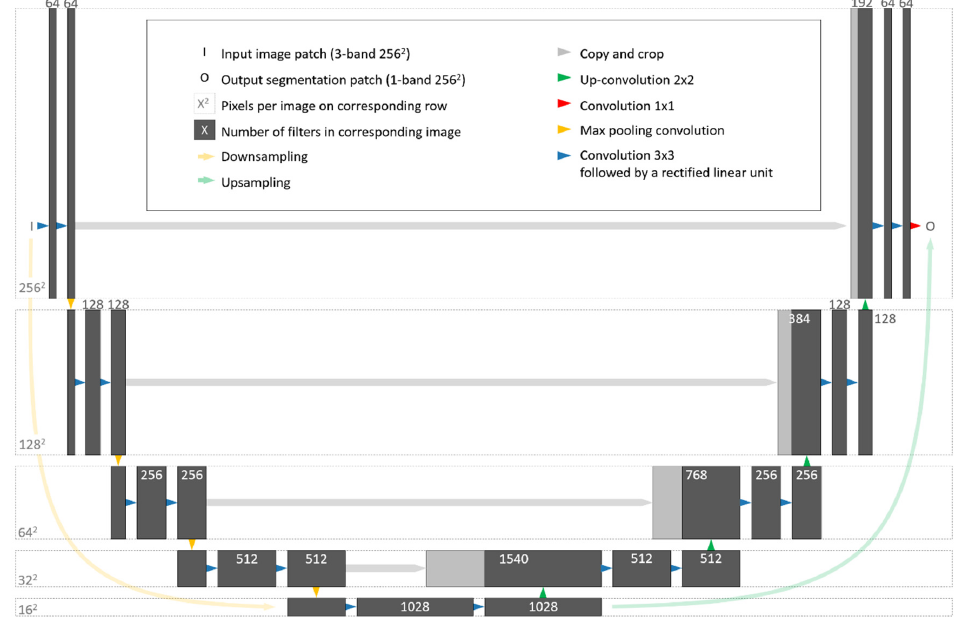
Figure 4. The U-Net architecture, starting with an input image patch (top-left) and ending with an output segmentation patch (top-right) [33].